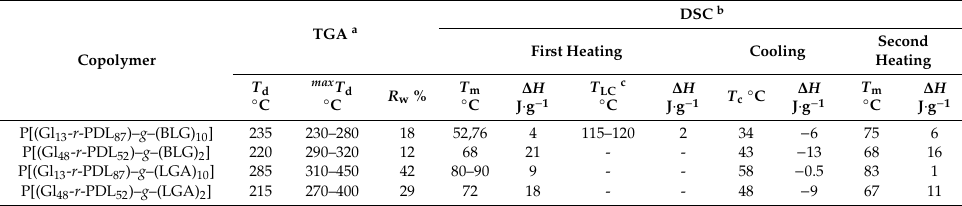
11 max T d ) and remaining